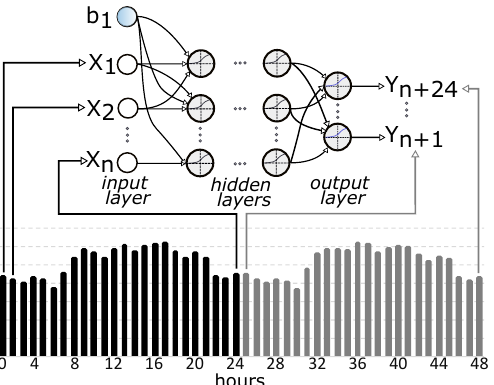
Figure 3. Supervised learning with neural networks for